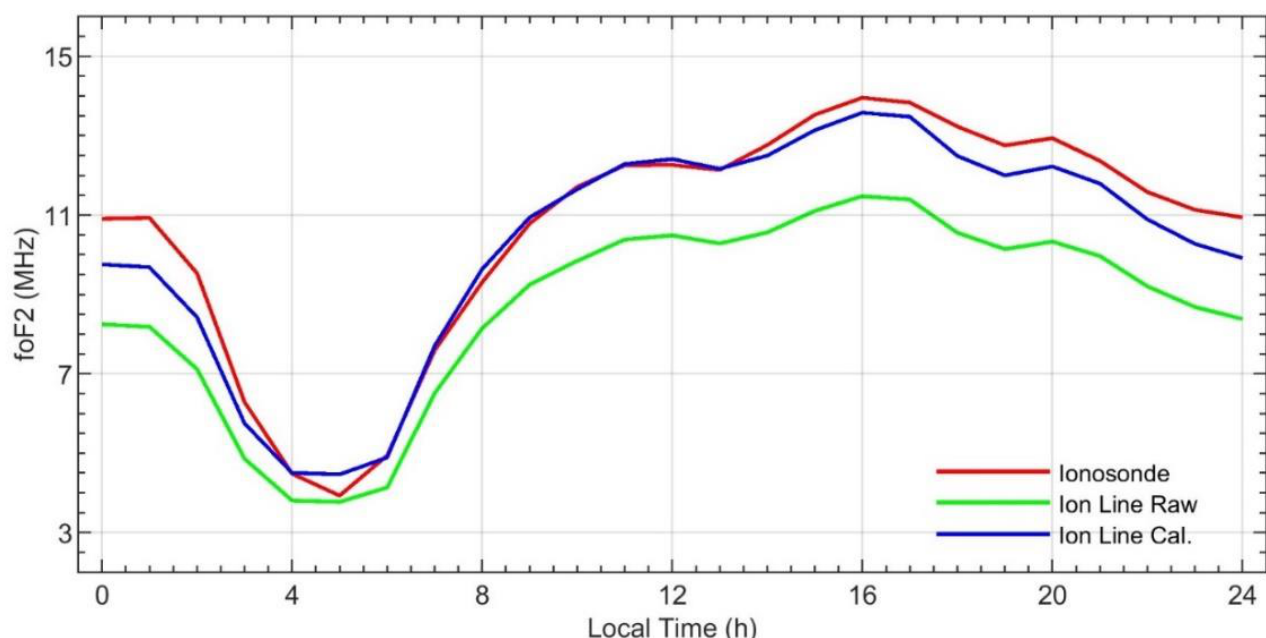
Figure 6. Local time variation of mean f o F 2 during 12 March 2022 to 10 April 2022 of ionosonde measurements (red), SYISR ion line before calibration (green) and after calibration (blue).